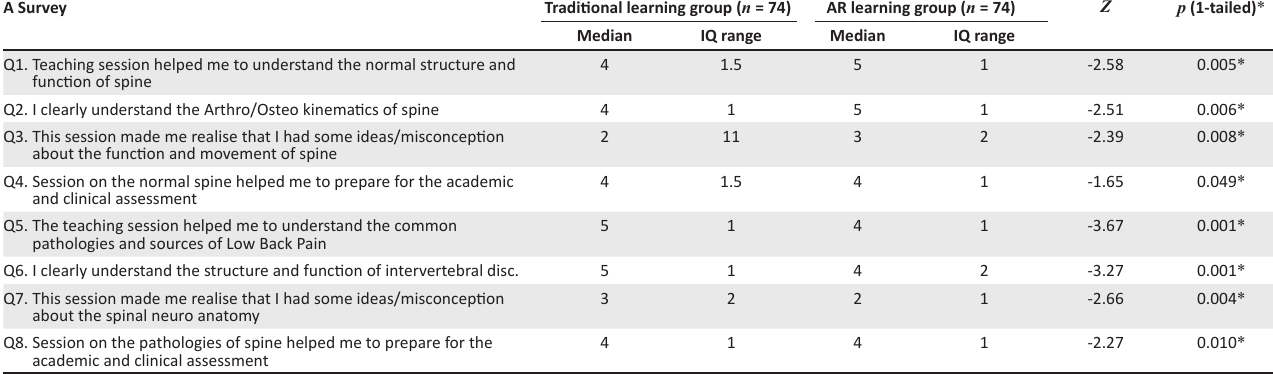
TABLE 4: Comparison of students learning experience between traditional and vision-based augmented reality learning group after tasks 1 and 2 ( n = 74). A